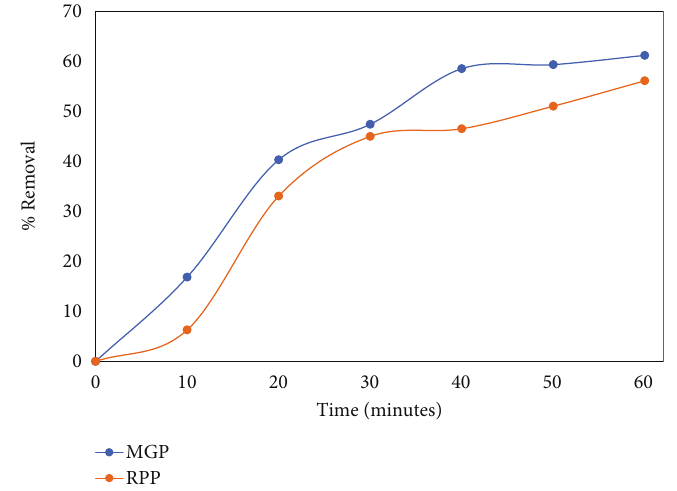
Figure 9: Removal percentage of methyl red dye by marigold and rose petal powder as